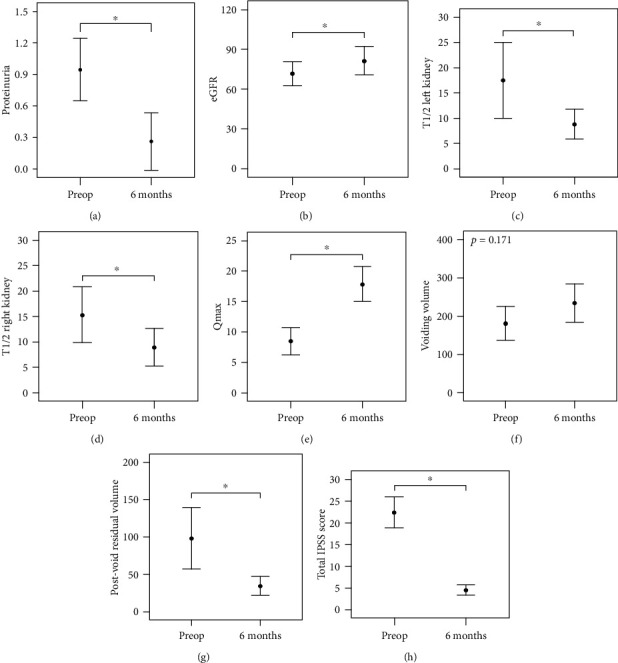
Changes in parameters before and at 6 months after the decompression of BPO. (a, b) Renal function was improved. (c, d) The T1/2 of diuretic 99mTc-MAG3 was improved. (e–g) The mean values of Qmax, voiding volume, and PVR seemed to be enhanced, but voiding volume did not significantly increase. (h) The IPSS score was markedly improved. BPO: benign prostatic obstruction; PVR: postvoid residual urine volume; IPSS: international prostate symptom score. Asterisk (∗) means p < 0.05.